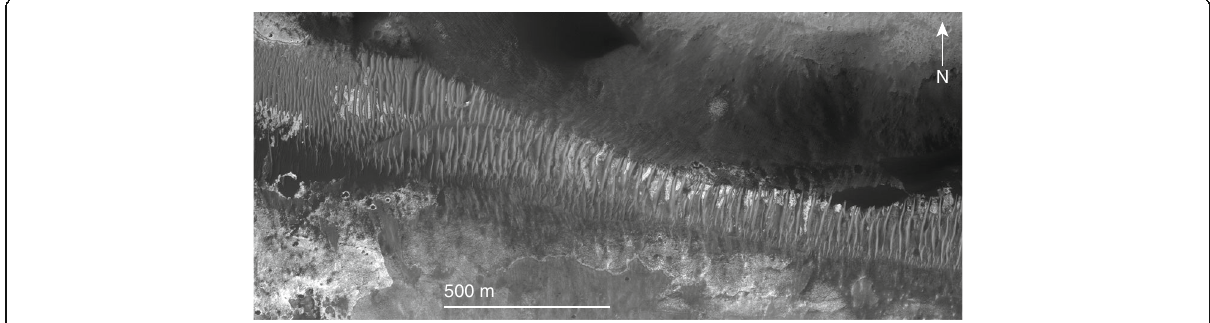
Fig. 8 Aeolian dunes in a channel on